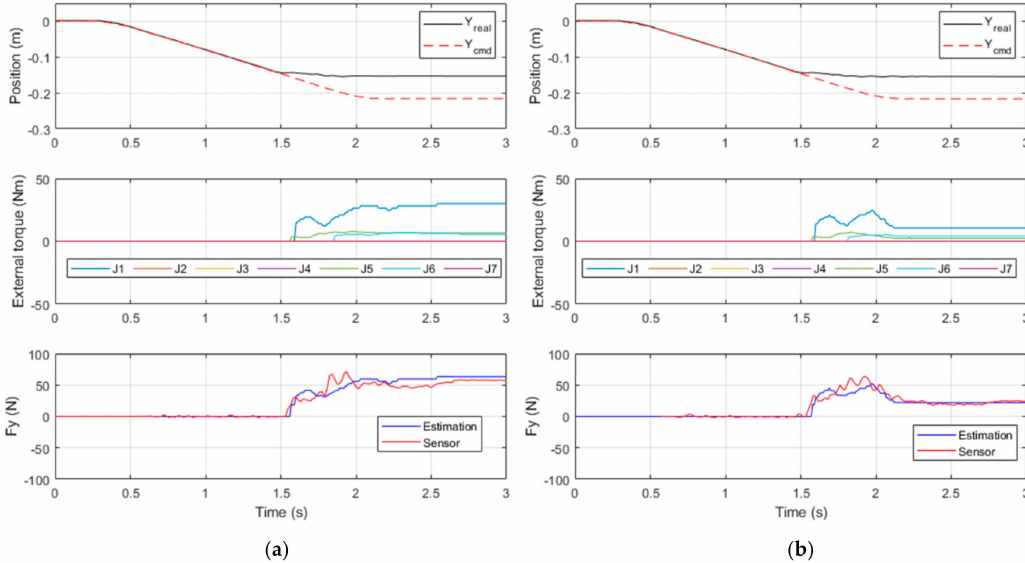
Figure 13. Results of collision detection without safety control ( a ) and with safety control ( b